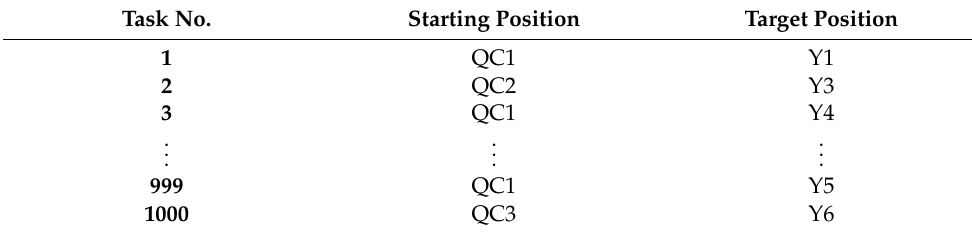
Table 5. Container task